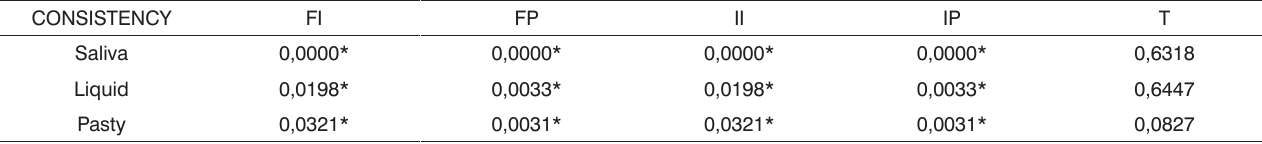
Tabela 9. Significância para cada consistência nas três subfaixas etárias (sexo feminino).